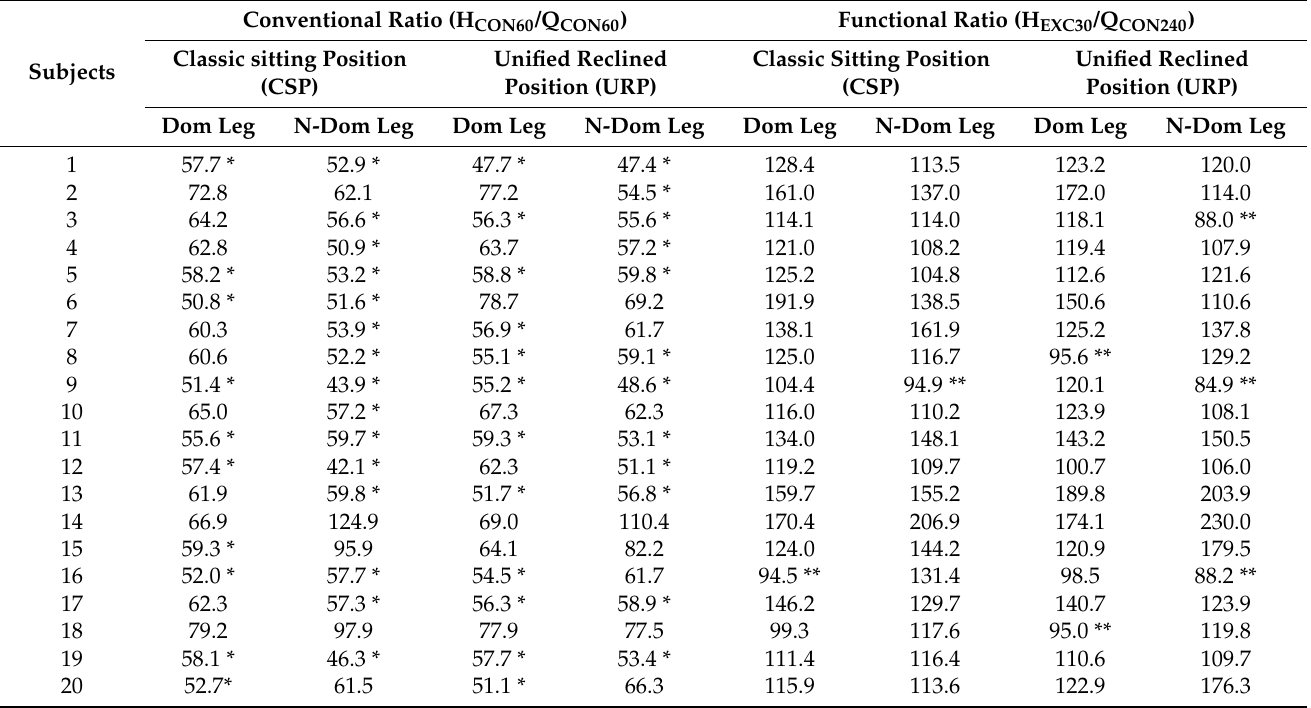
Table A2. Individual values of conventional (H CON60 /Q CON60 ) and functional (H EXC30 /Q CON240